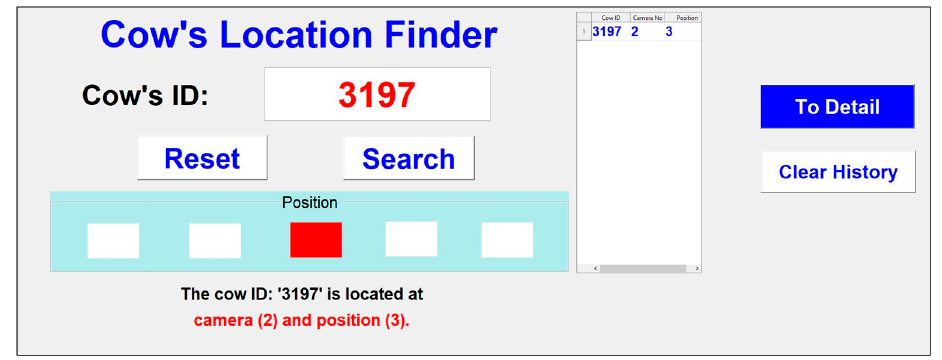
Figure 22. Design for the search system user interface.